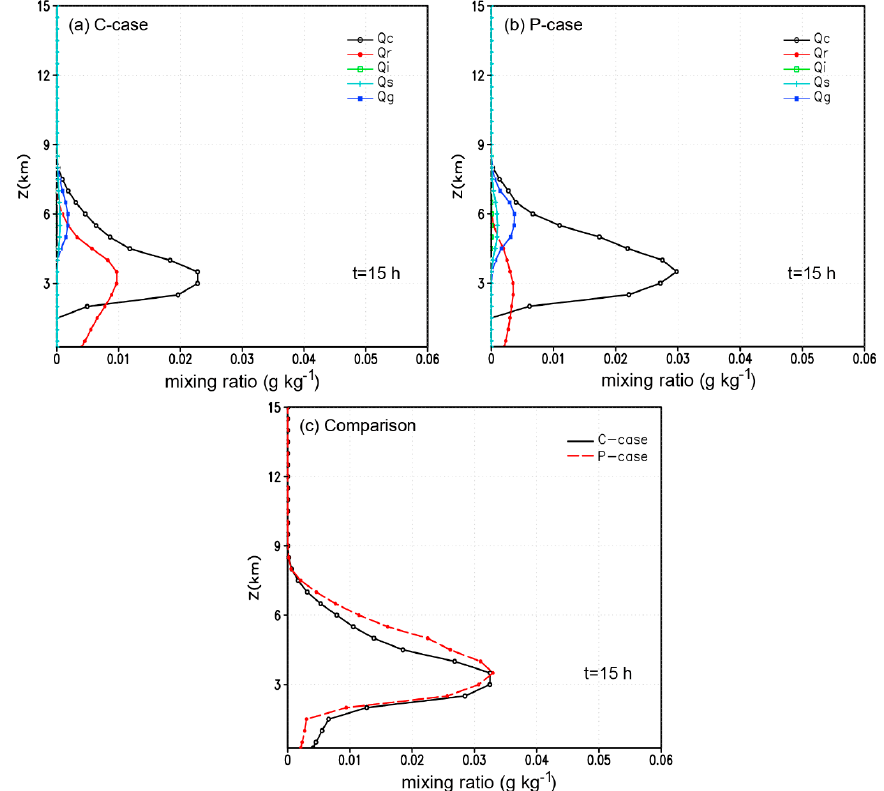
Figure 5. Vertical profiles of domain-averaged mixing ratios (g kg − 1 ) of hydrometeors at t = 15 h ( a ) C-case, ( b ) P-case, ( c ) Vertical Profile of Total Hydrometeors in two cases. The symbols Q c , Q r , Q i , Q s , and Q g represent the mixing ratios of cloud water, rain water, ice crystals, snow, and graupel, respectively.